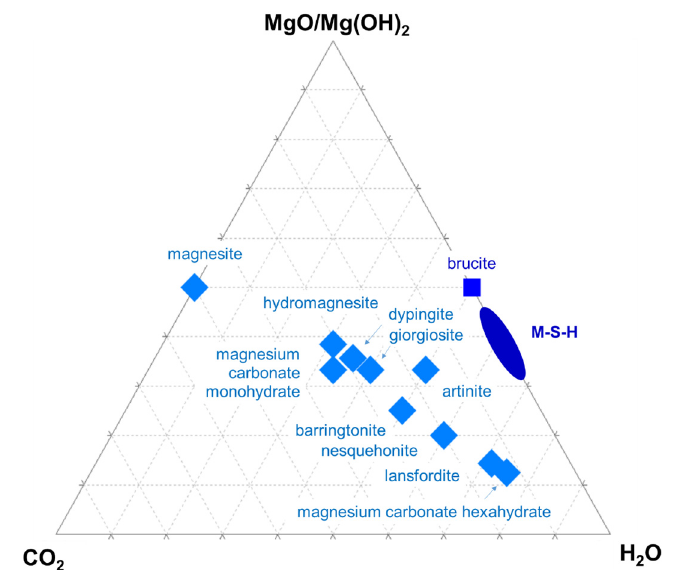
Figure 8. MgO ‐ CO 2 ‐ H 2 O ternary plots based on the composition of the different magnesium carbonates and M ‐ S ‐ H phases (silica is only present in M ‐ S ‐ H). Adapted from